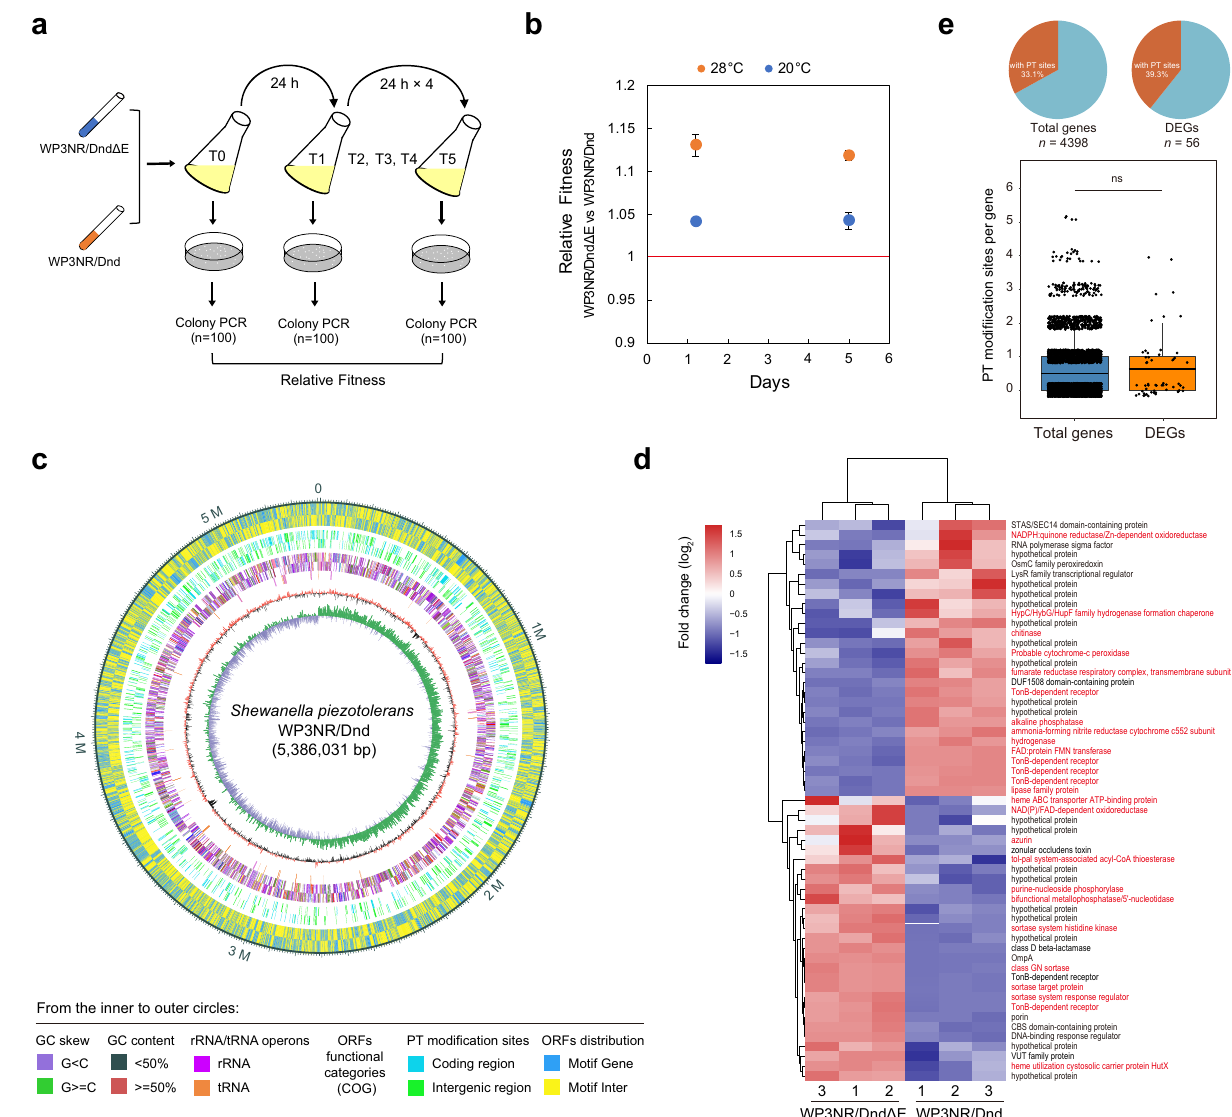
Fig. 6 The horizontally transferred dnd gene cluster substantially reduces the fi tness of the deep-sea bacterium S. piezotolerans WP3. a Experimental scheme of competition experiments performed. Co-culture competition assays were performed in 2216E media at 28 °C and 20 °C. The details can be found in the Methods section. b Fitness measurements of two WP3 strains (WP3NR/Dnd Δ E vs. WP3NR/Dnd) at different temperatures. The red line indicates a relative fi tness of 1 (no fi tness difference). Data are represented as mean ± s.d. and based on three biologically independent samples. c Detection of PT sites by SMRT sequencing across the genome of S. piezotolerans WP3NR/Dnd. The annotations from the inner to outer circles are indicated below the diagram. d Comparison of gene expression pro fi les in WP3NR/Dnd relative to WP3NR/Dnd Δ E. The RNA-seq data represent three biologically independent samples for each strain, and the data were hierarchically clustered. Normalized differential expression is shown in the heat map according to the scale bar (log 2 scale) from most upregulated (red) to most downregulated (blue). The DEGs involved in metabolic function are indicated in red in the right panel. e Distribution of PT sites within the DEGs. The genomic PT pro fi le and transcriptome data were combined to reveal the relationship between them. Boxplot components: center line, median; box limits, upper and lower quartiles; whiskers, 1.5× interquartile range. The signi fi cance was analyzed by two-sided unpaired Student ’ s t test (ns, not signi fi cant, P = 0.3292). Source data are provided as a Source Data fi